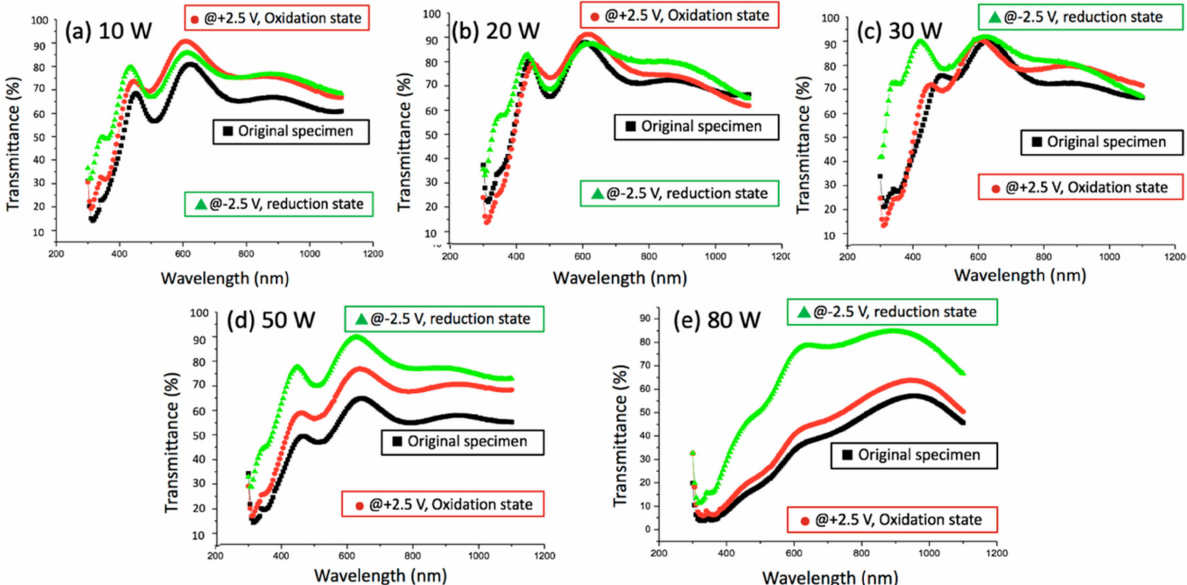
Figure 5. The transmittance of the Ni-V-O thin film, the original sample (square), colored sample (circle) and bleached (triangle) sample ( a ) 10, ( b ) 20, ( c ) 30, ( d ) 50, and ( e ) 80 W,